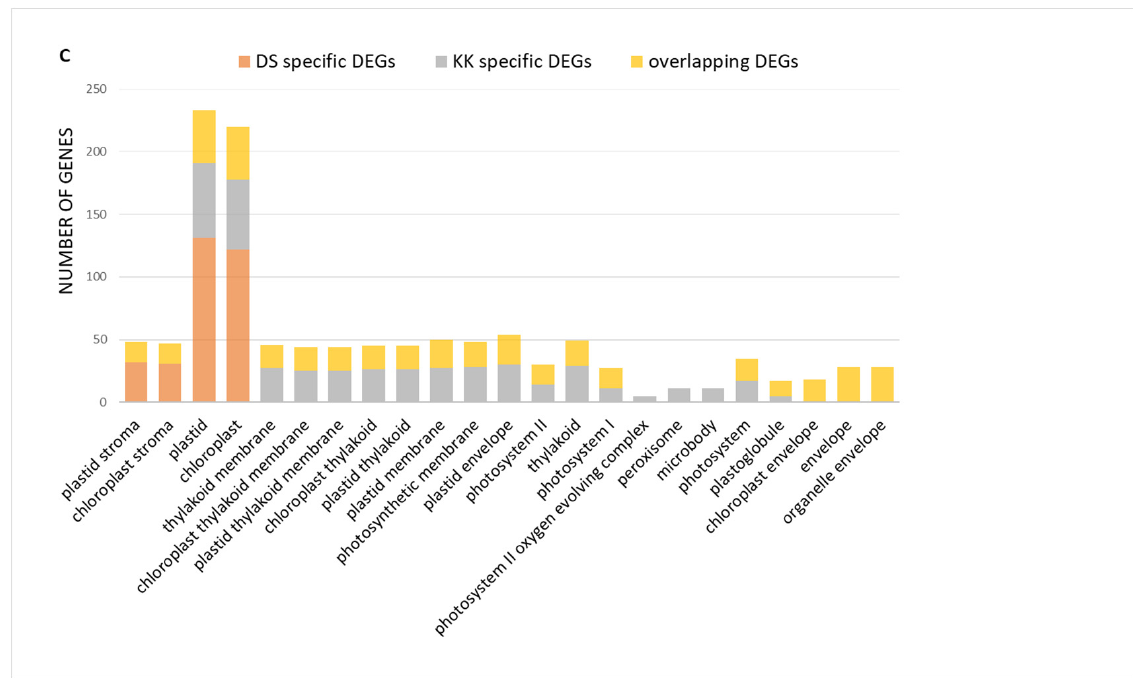
Figure 4. Gene ontology enrichment analysis of DEGs in the two pepper cultivars . GO terms enriched in: molecular function ( A ), biological process ( B ), and cellular component ( C ) across DS-specific, KK-specific, and overlapping DEGs using g: Profiler (adj p < 0.05).